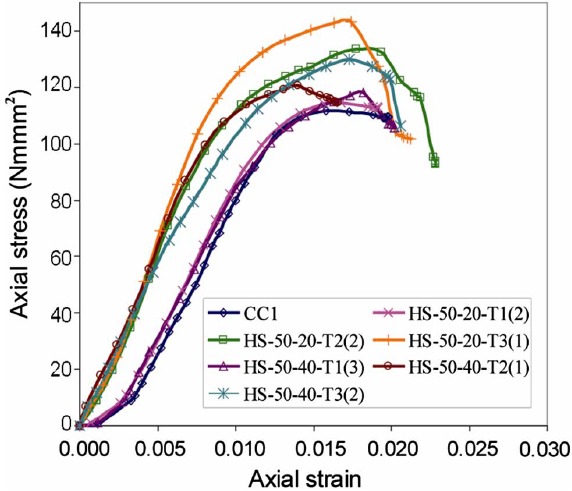
Fig. 13. Axial stress strain behaviour of all columns (cid:1) comparison